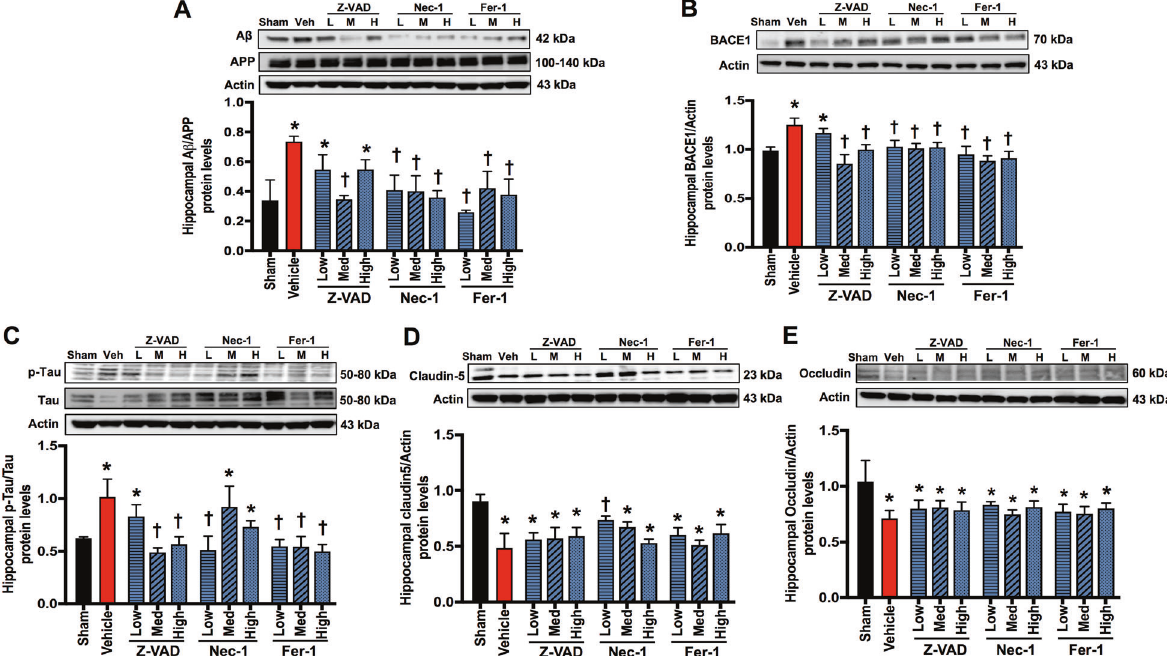
Fig. 3 The effects of cell death inhibitors on Alzheimer ’ s disease-related protein levels and blood – brain barrier breakdown. A Hippocampal A β /APP protein expression; B hippocampal BACE1 protein expression; C hippocampal p-Tau/Tau protein expression; D , E hippocampal tight junction protein claudin 5 ( D ) and occludin ( E ) expression. Data are shown as mean ± SEM. * P < 0.05 vs. Sham, † P < 0.05 vs . Cardiac I/R + Vehicle; n = 6/group. Veh: cardiac I/R rats treated with vehicle; L: cardiac I/R rats treated with low dose of cell death inhibitor; M: cardiac I/R rats treated with medium dose of cell death inhibitor; H: cardiac I/R rats treated with high dose of cell death inhibitor. I/R ischemia/ reperfusion injury, A β amyloid beta, APP amyloid precursor protein, BACE β -site amyloid β precursor protein (APP)-cleaving enzyme.